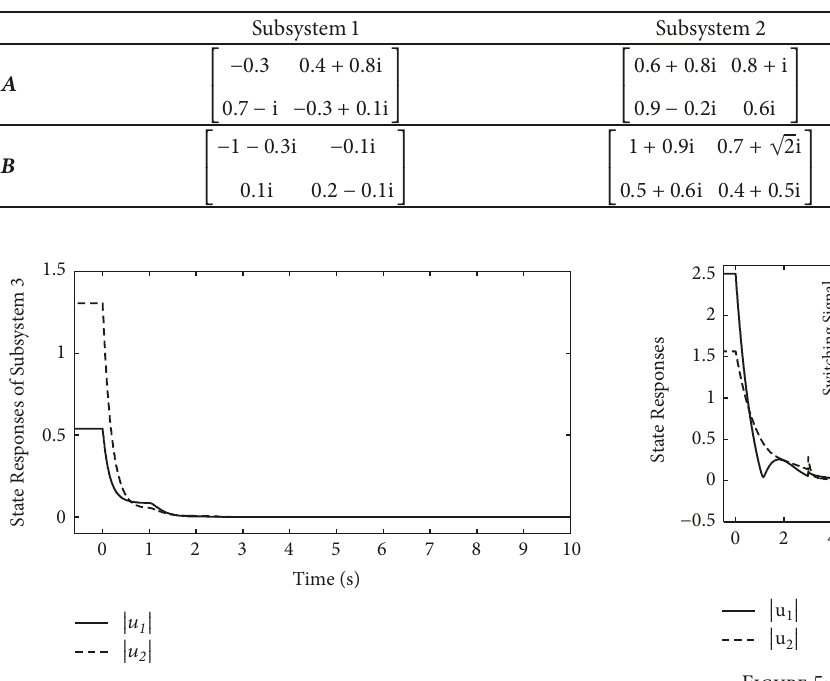
Table 4: Interconnected matrices in (2) for numerical simulation.